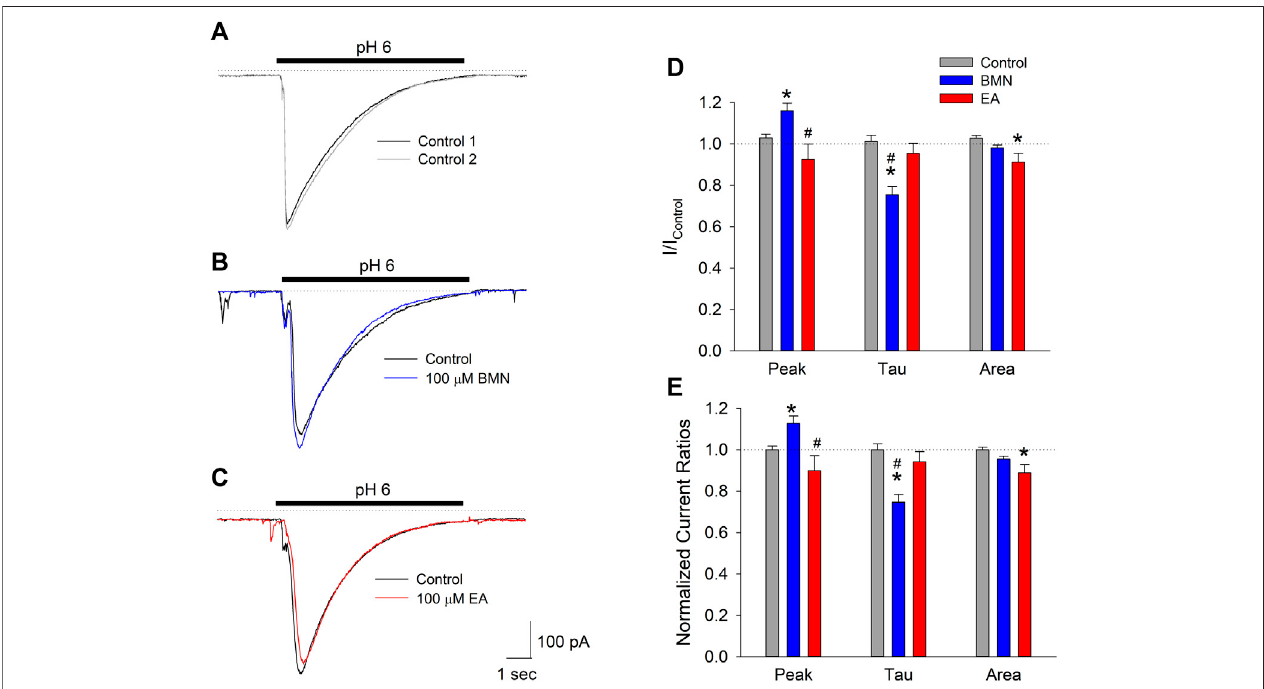
FIGURE3| PeakinwardASIC-mediatedcurrentsarenotinhibitedbybumetanideorethacrynicacid. (A) ,Representativetracesofinwardcurrentsactivatedbytwo 10 sapplications ofacidic solution (pH 6.0) onto a single cell voltage clamped at − 70 mV. (B) , Representative traces ofinward currents activated by 10 s applicationsof PSS at pH 6.0 onto a single cell voltage-clamped at − 70 mV in the absence (Control, black trace) and presence of 100 μ M bumetanide (100 μ M BMN, blue trace). (C) , Representative traces of inward currents activated by 10 s applications of PSS at pH 6.0 onto a single cell voltage-clamped at − 70 mV in the absence (Control, black trace) and presence of 100 μ M ethacrynic acid (100 μ M EA, red trace). (D) , Mean peak inward currents, rates of current decay ( τ ) and net current (area under current trace) ( ± SEM) measured in the absence (Control, n (cid:1) 16) and presence of100 μ M bumetanide (BMN, n (cid:1) 6) and 100 μ M ethacrynic acid (EA, n (cid:1) 10) normalized toinitialcontrolresponses(absenceofdrugs). (E) ,Datain (D )normalizedtoResponse2/Response1ratioforControl.Asterisksdenotesigni fi cantdifferencefromControl ( p < 0.05) and pound symbols indicate signi fi cant difference between BMN and EA ( p < 0.05). Bars above (A) , (B) , and (C) indicate duration of low pH application